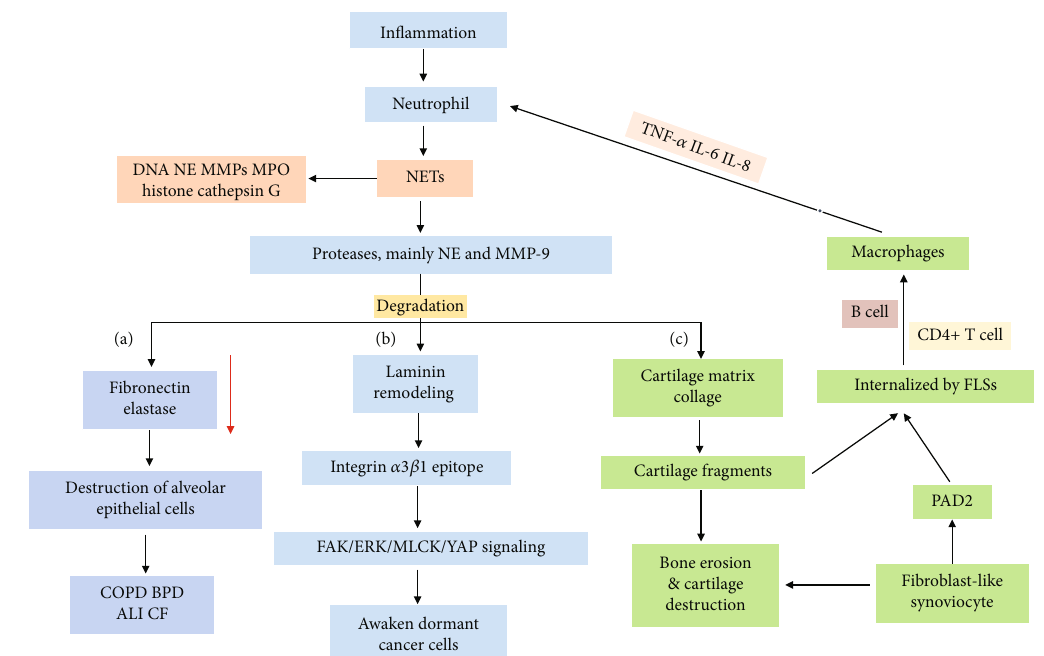
Figure 1: Regulation of ECM by neutrophil extracellular traps in diseases. NETs cleaved ECM in alveolar epithelial cells mainly via elastase and MMP-9, which destroyed the tight junctions between cells and increased tissue permeability, promoting the development of lung diseases. (b) Sustained in fl ammation induced the formation of neutrophil extracellular traps (NETs), and NET-associated proteases (NE, MMP-9) initiate awakening of dormant cancer cells by ECM remodeling. (c) Cytokines activate neutrophils to release elastase and MMP-9, which can directly degrade cartilage components in the synovium, promoting cartilage